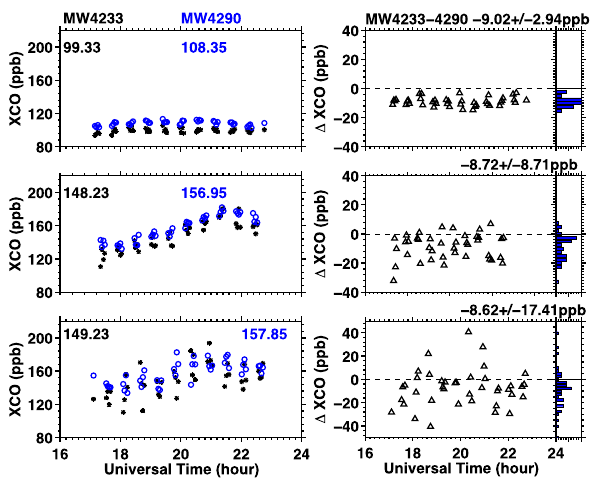
Figure 12 . XCO (in parts per billion (ppb)) measured by CLARS-FTS with MW4233 (black dots) and MW4290 (blue circles) on 3 January 2013 (left panels), and differences of retrieved XCO be- tween the two spectral regions and the histograms (right panels) in the Spectralon ® viewing (top panels), towards Santa Anita Park (middle panels), and towards west Pasadena (bottom panels). Com- pared to the background levels of XCO (top panels), XCO over Santa Anita Park (middle panels) and west Pasadena (bottom pan- els) shows higher values (mean SAP-SV: 48.75ppb; mean WP-SV: 49.70ppb) and presents stronger diurnal cycles than those mea- surements over the CLARS site. The XCO values retrieved from MW4290 are higher than those of MW4233. The mean differences between MW4290 and MW4233 are 9.02, 8.72, and 8.62ppb for SV, SAP, and WP, respectively. These systematic differences of re- trieved XCO values between two spectral bands have likely arisen from the discrepancies of spectroscopic parameters between two spectral bands and the amount/intensity of spectral features of in- terfering species.